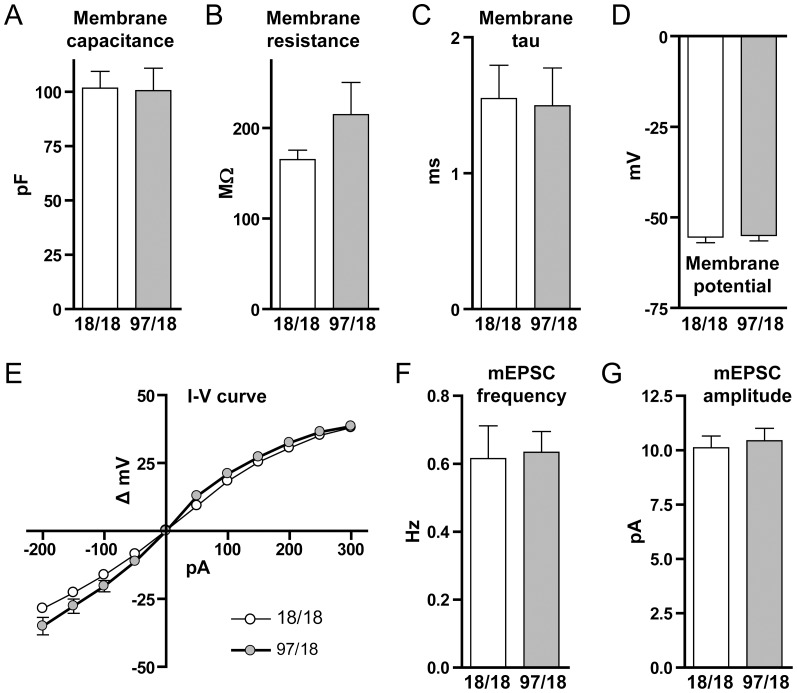
Whole-cell properties of CA1 pyramidal neurons from Hu18/18 and Hu97/18 mice at 9 months of age.(A–D) Whole-cell patch recordings from CA1 pyramidal neurons revealed no difference in membrane properties including membrane capacitance (Cm, Hu18/18 n = 14, Hu97/18 n = 11), membrane resistance (Rm, Hu18/18 n = 14, Hu97/18 n = 11), membrane tau (ôm, Hu18/18 n = 14, Hu97/18 n = 11) or resting membrane potential (Em, Hu18/18 n = 14, Hu97/18 n = 13). I–V plots (E, Hu18/18 n = 14, Hu97/18 n = 13), mEPSC frequency (F, Hu18/18 n = 13, Hu97/18 n = 13) and mEPSC amplitude (G, Hu18/18 n = 13, Hu97/18 n = 13) were also similar between genotypes.